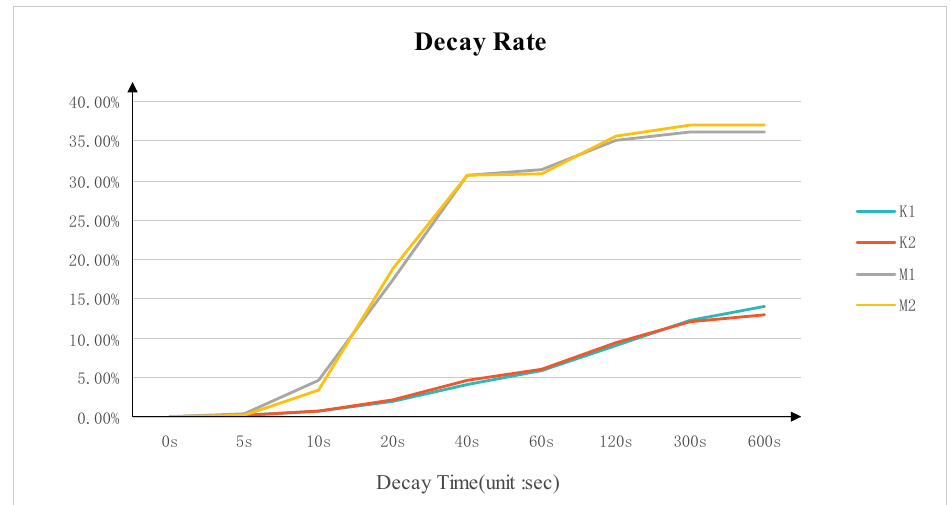
Figure 6. Decay rate for different DDR3